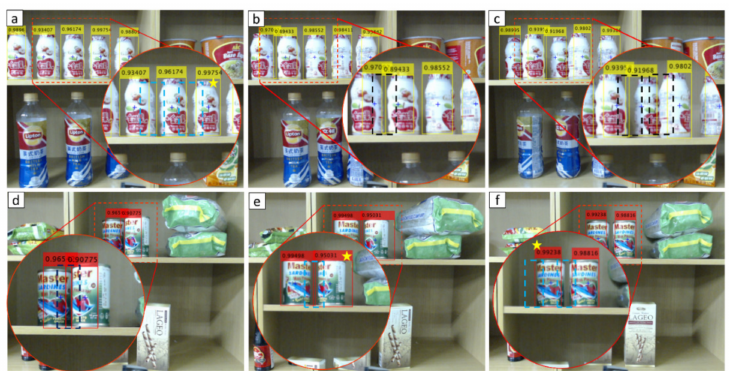
Figure 11. The possibility of detection on purchased products in one column of shelf; ( a ) multi- detected purchased products on inline layout and dashed-green line shown the safe narrow space for a gripper, ( b ) the overlapped bounding boxes of purchased products on inline layout, ( c ) the overlapped bounding boxes form overlapped products, ( d ) the overlapped bounding box on mixed products, ( e ) the overlapped bounding box on mixed products with yellow-star as a chosen to pick, and ( f ) the mixed products on one shelf with safe edge collision. In real space, the dashed-black line indicates it cannot be reached by the gripper and ( a – c ) as a left, while ( d – f ) as a right half